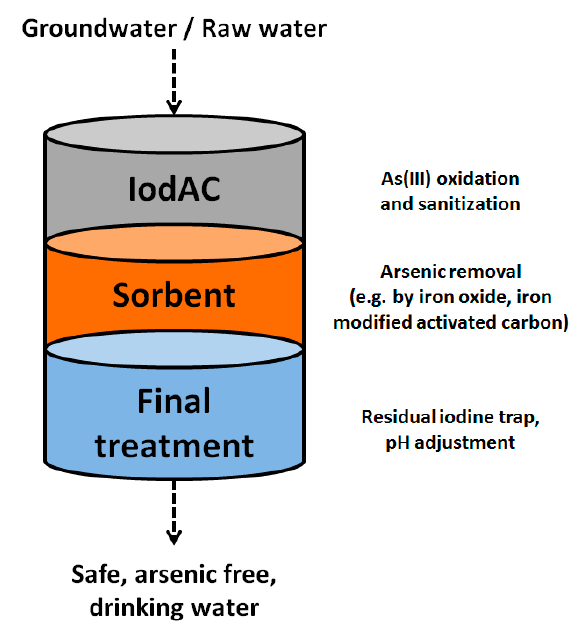
Figure 8. Model for the application of IodAC in an integrated, multipurpose, water treatment system or cartridge.